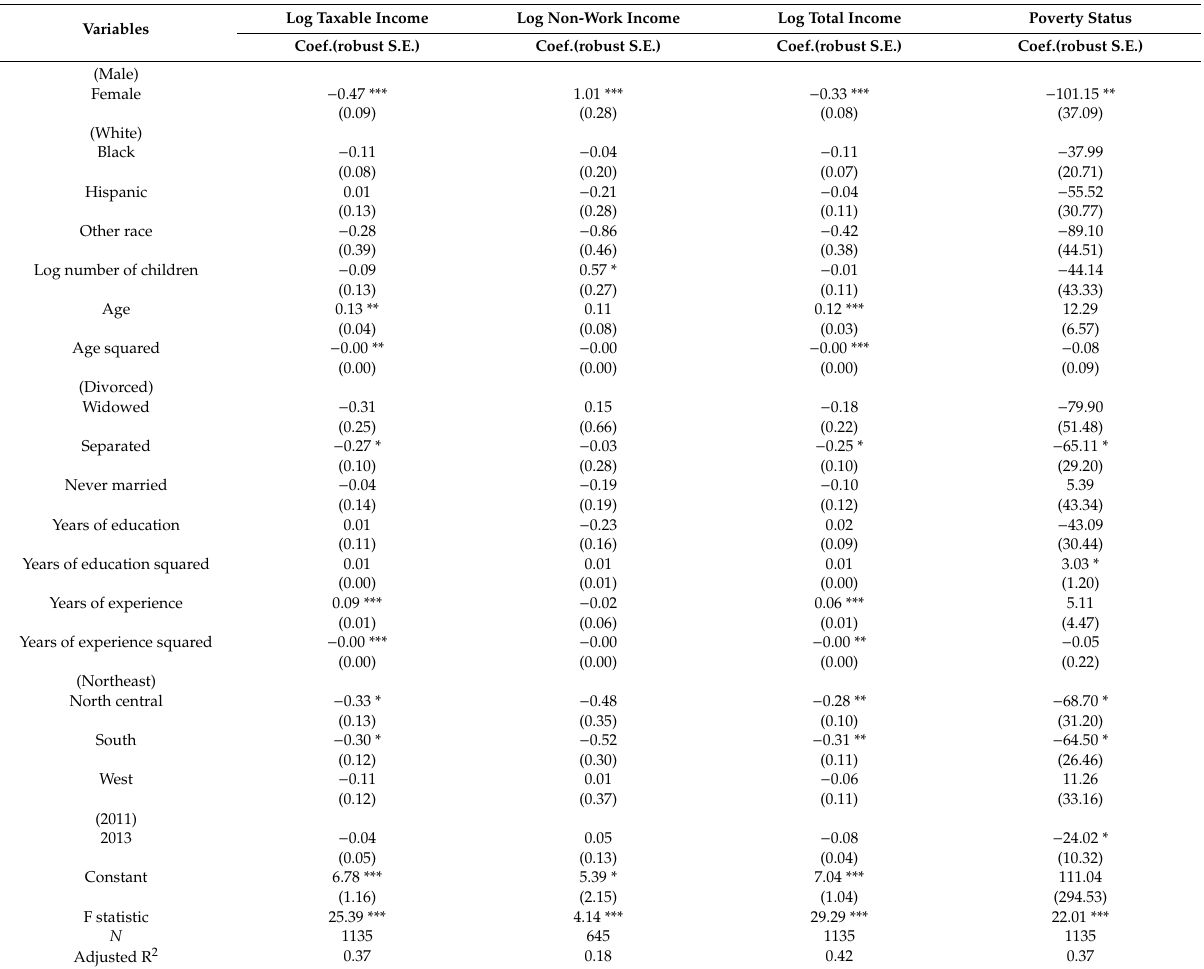
Table 3. Multivariate regression coe ffi cients of independent variables predicting log taxable income, log non-work income, log total income, and poverty status for the full